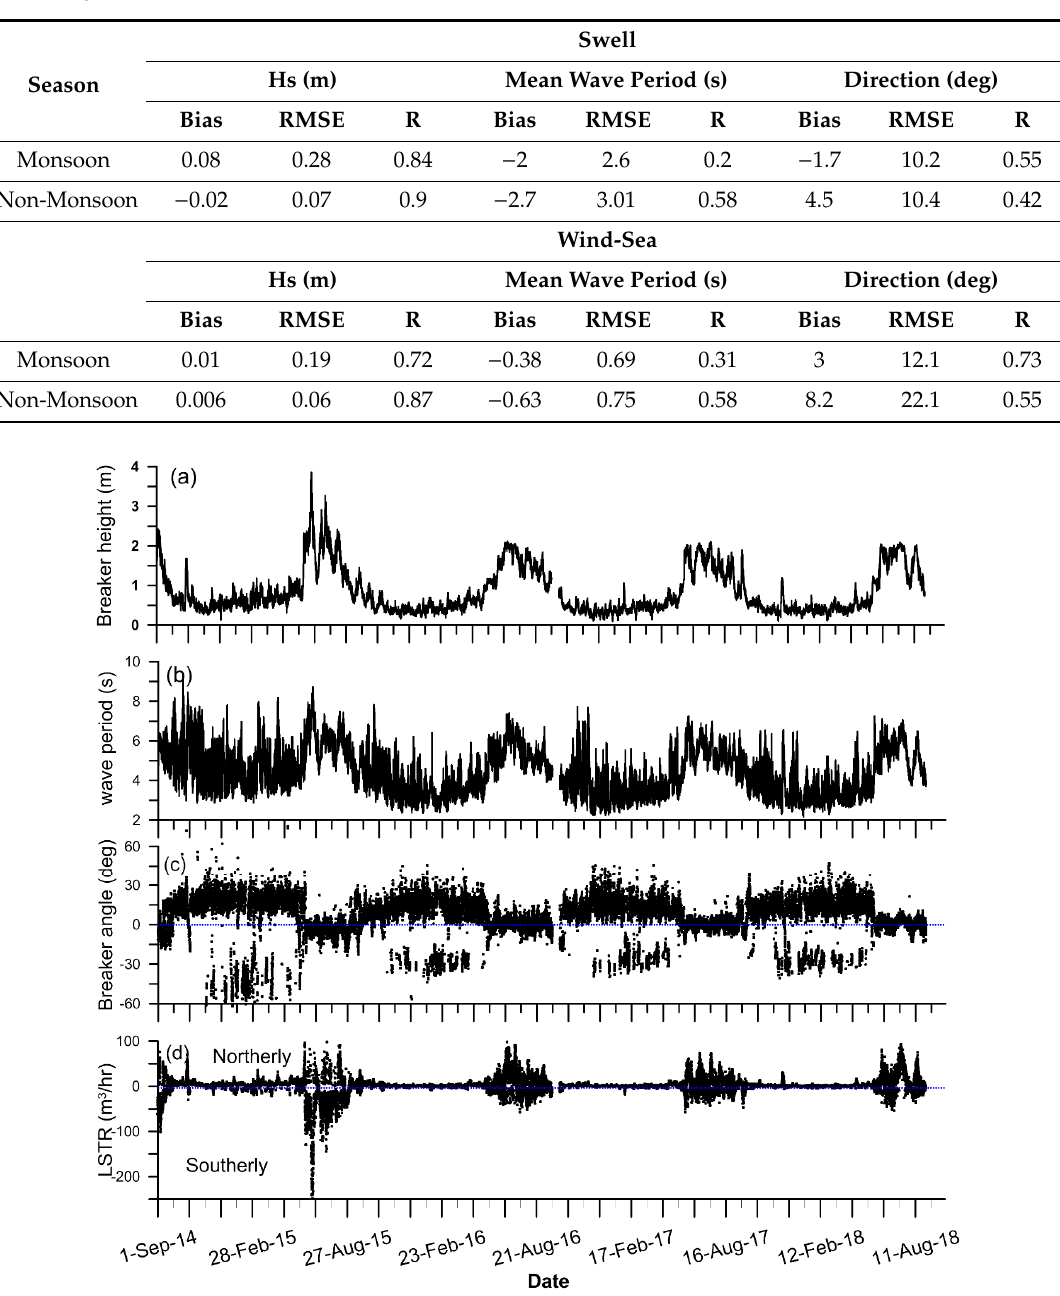
Figure 7. Time series plot for ( a ) breaker height, ( b ) wave period ( c ) wave breaker angle, and ( d ) longshore sediment transport